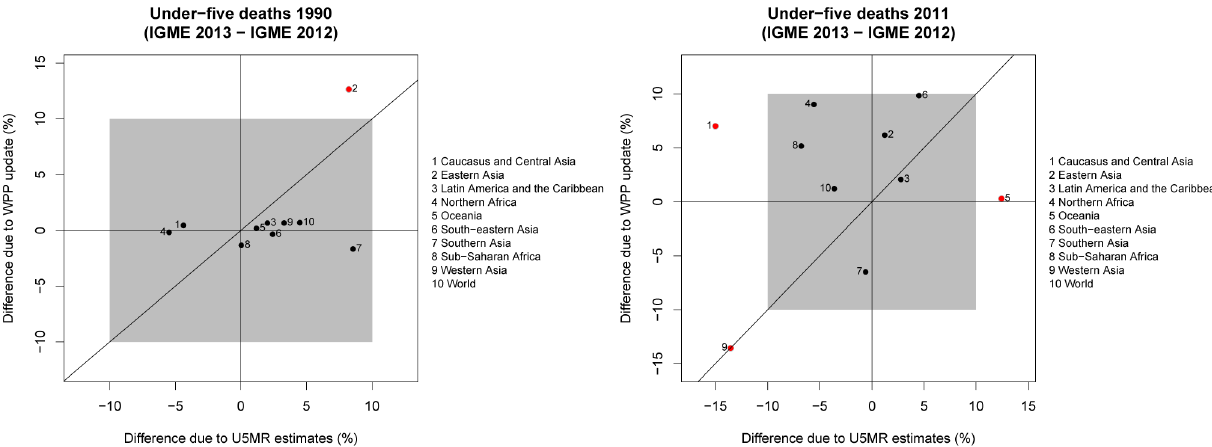
Figure 10. Decomposition of differences in under-five deaths in 1990 and 2011 into differences due to the WPP update and differences due to updates in U5MR estimates. The gray box represents differences up to 10%. Regions with differences of more than 10% due to either factor are highlighted in red.